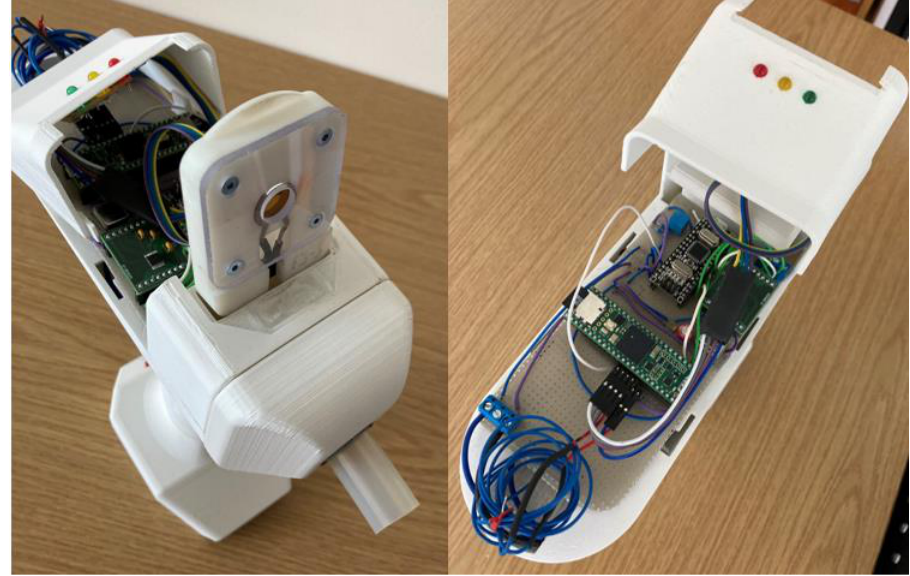
Figure 11. Pictures of the breathalyzer device showing the removable sensor cartridge ( left ) and the reading electronics and LED indicators ( right ).